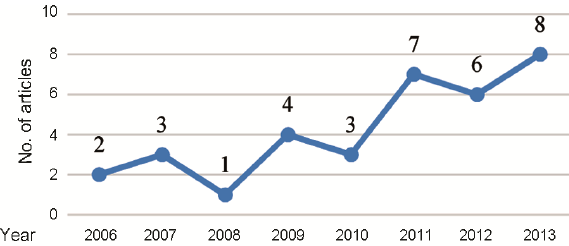
Fig. 2. Articles published between 2006 and 2013 on